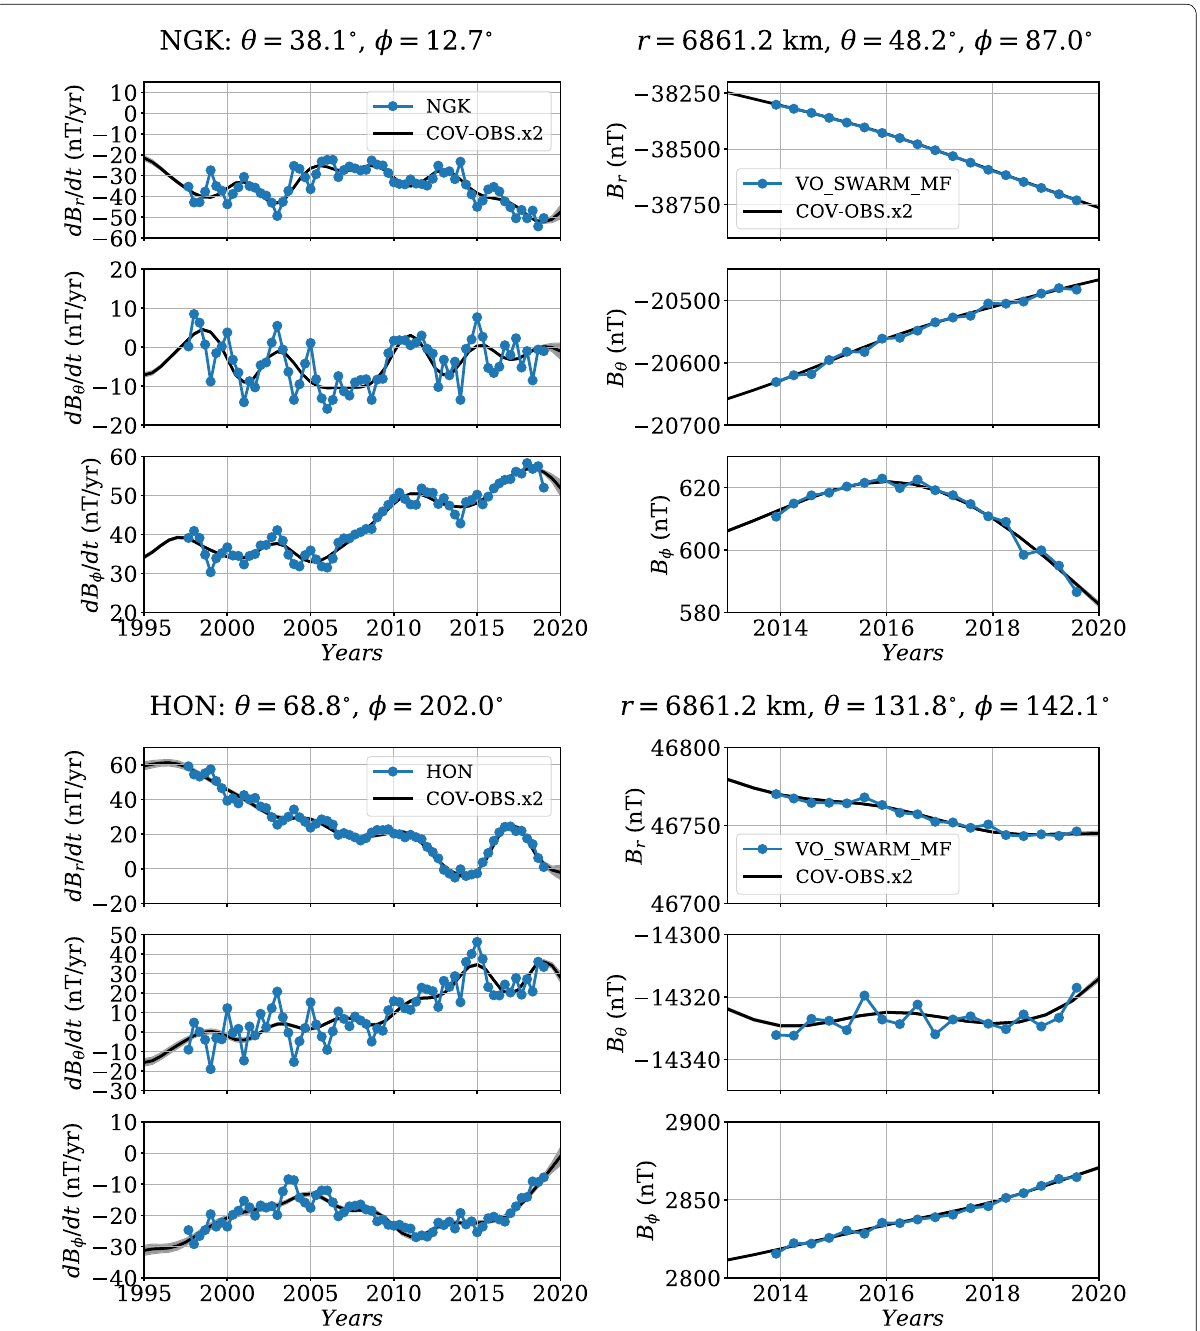
Fig. 4 Predictions from COV-OBS.x2 for the three geocentric components. Left: SV at the Niemegk (NGK, top) and Honolulu (HON, bottom) observatories. Right: MF at two examples of Swarm VO in the Northern (top) and Southern (bottom)